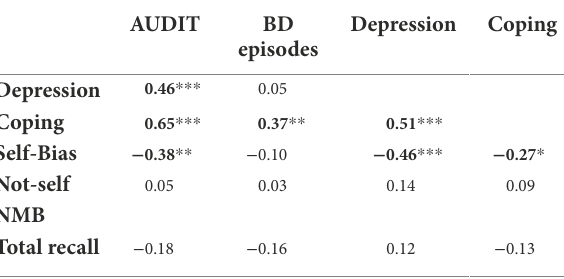
TABLE 2 Correlation matrix among the alcohol, clinical, and memory variables of interest in Study